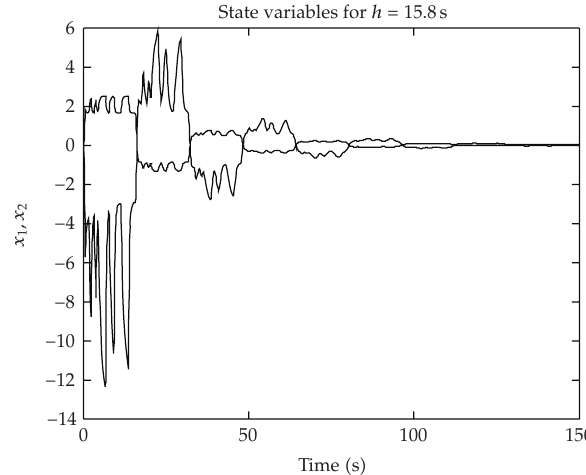
Figure 9: State trajectories evolution for a delay of 15.8